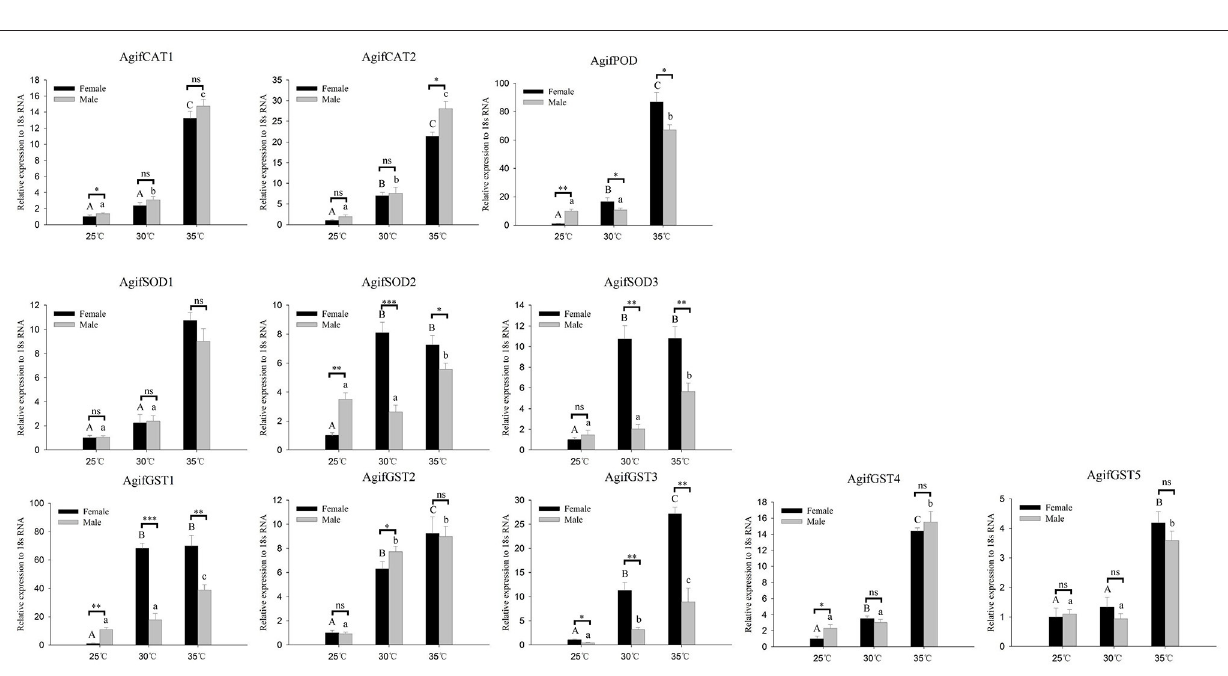
41 ◦ C in Propylaea japonica (Zhang S. Z. et al., 2015). Due to